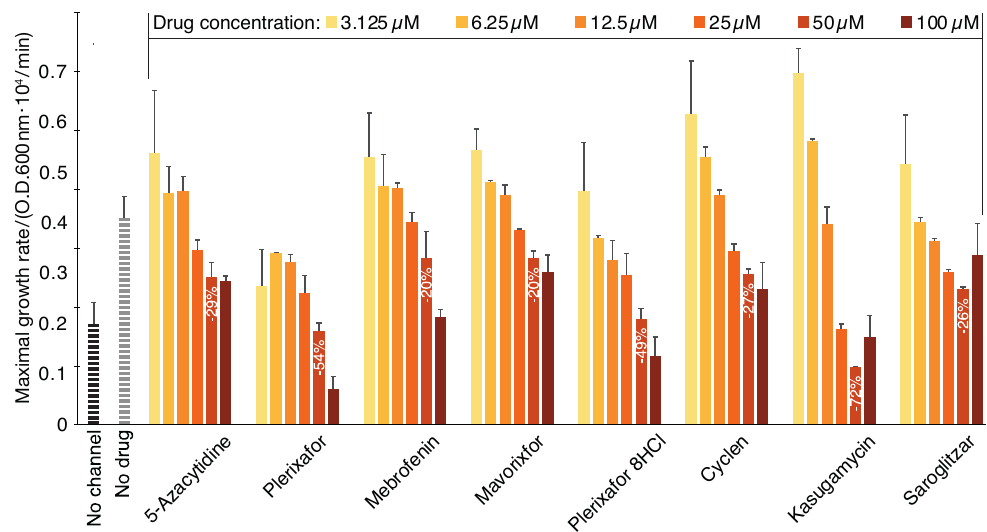
Figure 3. Compound screening results using the positive assay. SARS-CoV-2 E protein is expressed at a low level (20µM [ β - D -1-thiogalactopyranoside]) in K + -uptake deficient bacteria. In this instance, inhibitory drugs reduce bacterial growth. The results may be compared to those obtained without any drug (gray) or when the channel is uninduced (black). The color scale indicates the different concentrations of the